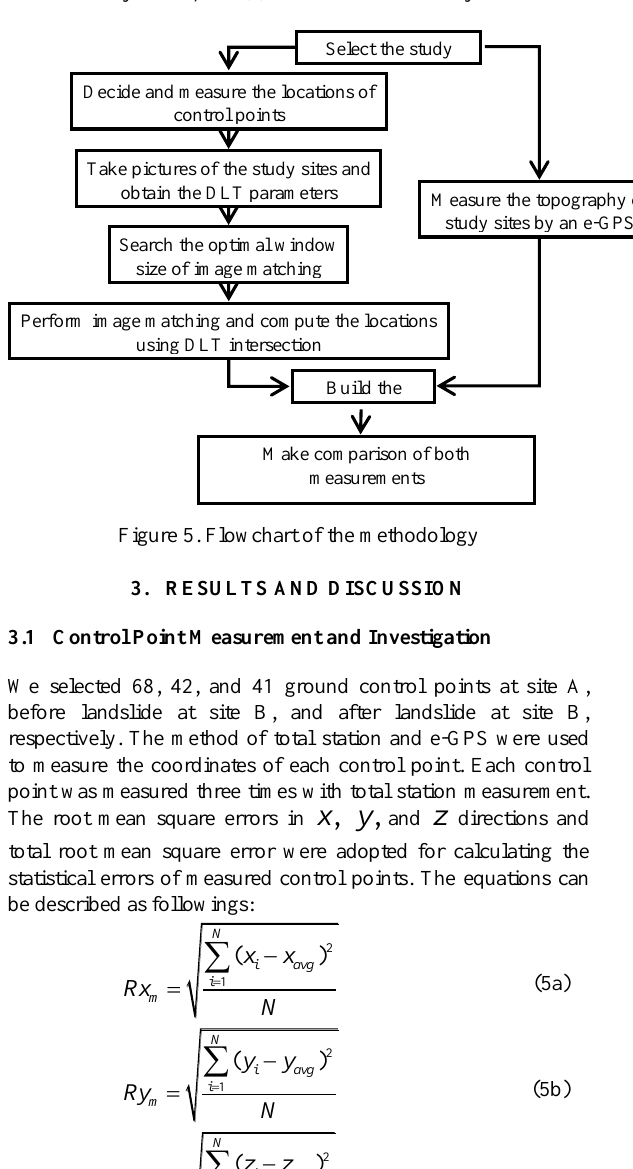
Figure 4. (a) The condition at study site A, (b) before landslide at study site B, and (c) after landslide at study site B